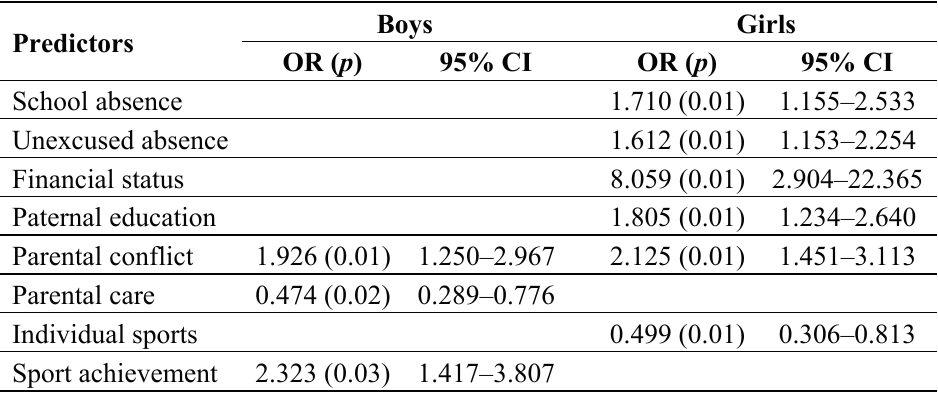
Table 4. Forward conditional logistic regression results for the criterion—consumption of the other drugs among boys and girls (OR—odds ratio; p —level of significance; CI—confidence